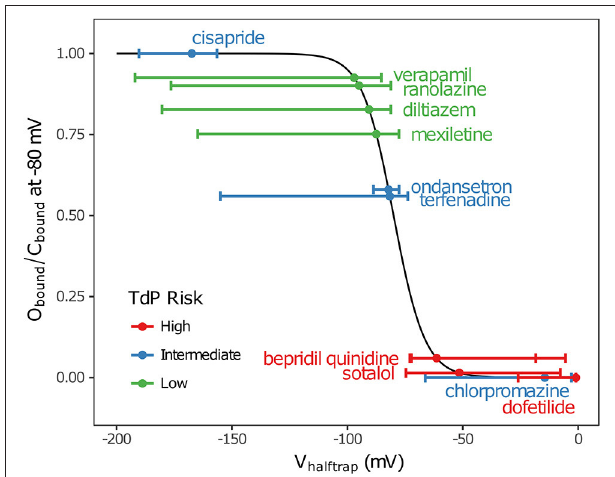
FIGURE 2 | Uncertainty in drug trapping for the 12 CiPA training drugs. Fitted V halftrap -values (points) are plotted along the curve defining the resulting steady-state fraction of open-bound to close-bound channels (O bound /C bound ) at V m = − 80mV. The 95% CIs (horizontal error bars) were estimated with bootstrapping. High TdP-risk drugs are in red, Intermediate-risk drugs are in blue, and Low-risk drugs are in green. Intermediate-risk drugs were indistinguishable from Low- and High-risk